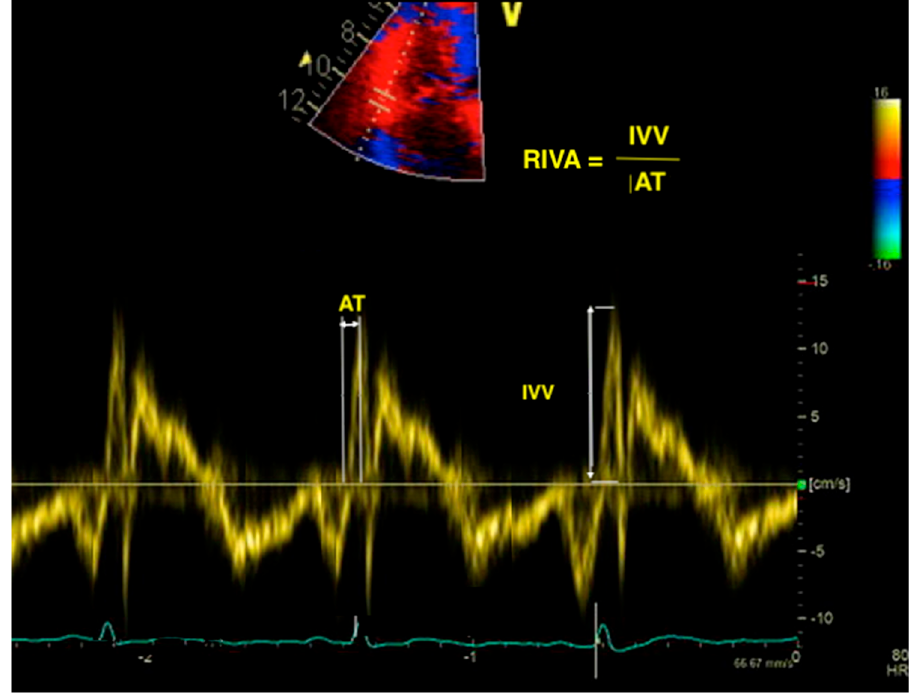
Figure 2. Calculation of RIVA using TDI. RIVA—right isovolumic acceleration; TDI—tissue Doppler imaging; IVV—isovolumic velocity; AT—acceleration time.